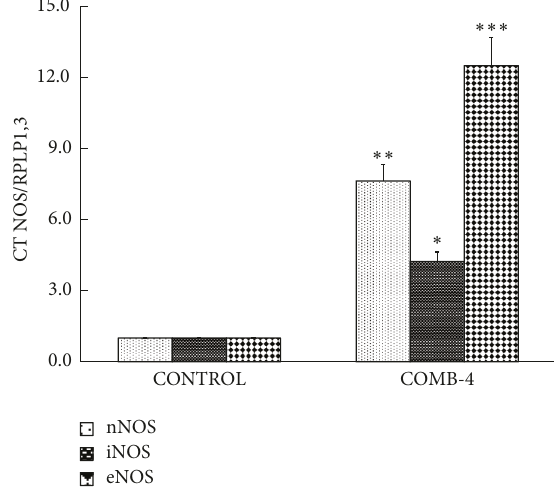
Figure 10: Effect of the incubation of COMB-4 on nNOS, iNOS, and eNOS mRNA expression in differentiated MC3T3-E1 cell line. Differentiated MC3T3-E1 cells were incubated with or without COMB-4 for 48 hours. mRNA expression for nNOS, eNOS, and iNOS was determined by qPCR. Results were expressed as x-fold increase with respect to the control of three experiments done in triplicate. ∗ p < 0.05; ∗∗ p < 0.01; ∗ ∗ ∗ p < 0.001 with respect to